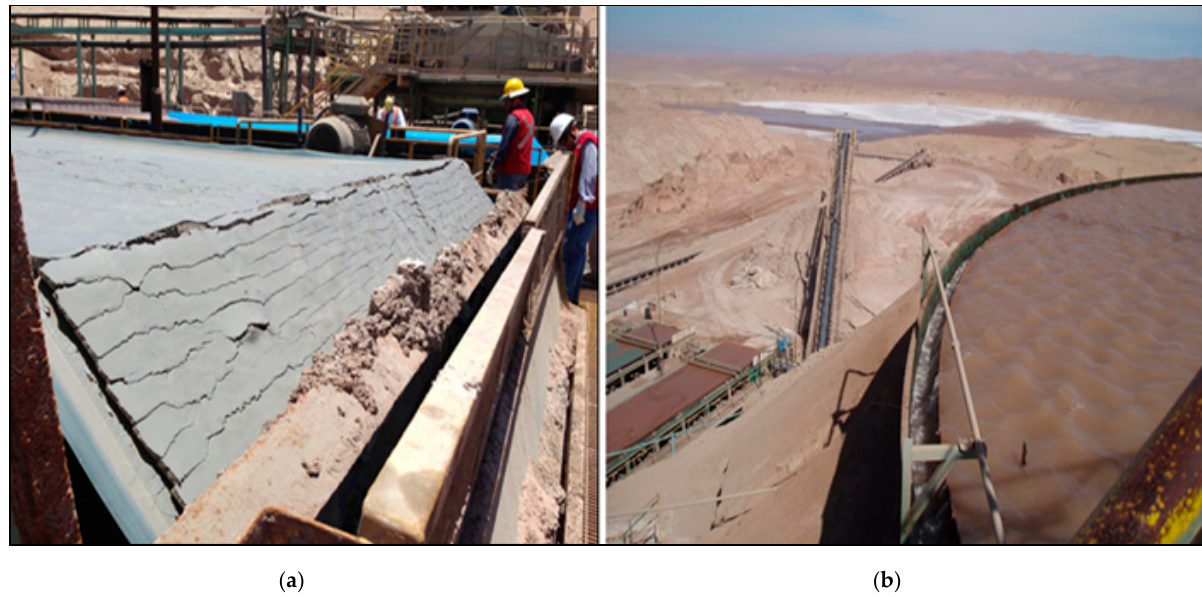
Figure 2. Dewatering of Mantos Blancos Coarse Tailings with Vacuum Belt Filters and Slimes Thick- ener Overview ( a ) Filtered Coarse Tailings with Vacuum Belt Filters, ( b ) Slimes Thickening Over- view.